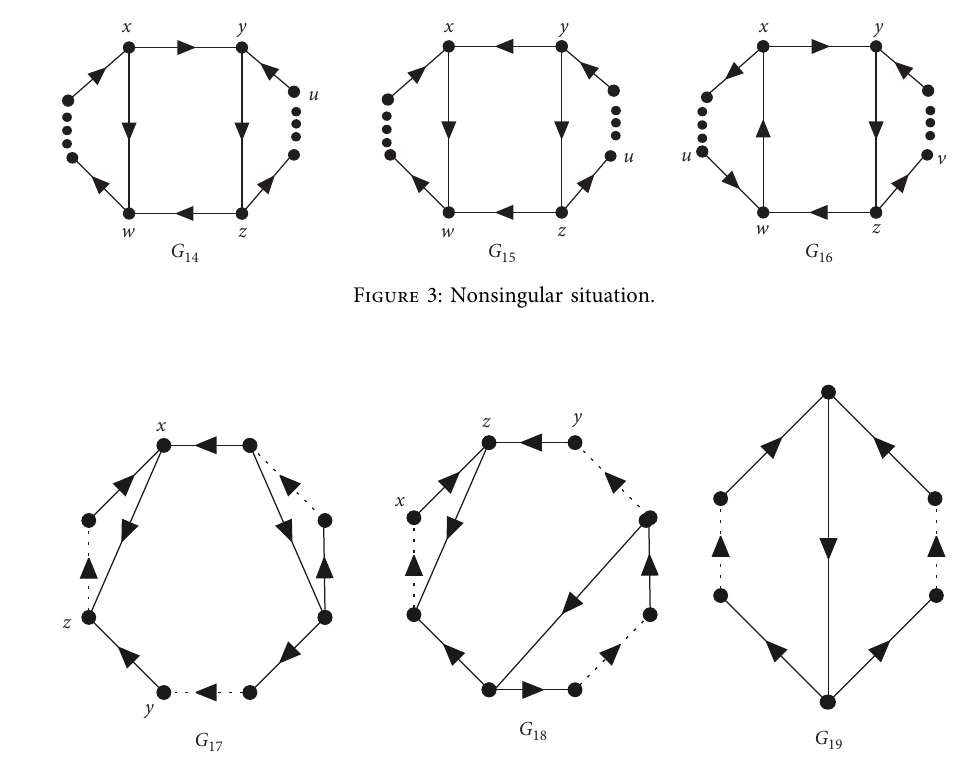
Figure 4: Singular situation.